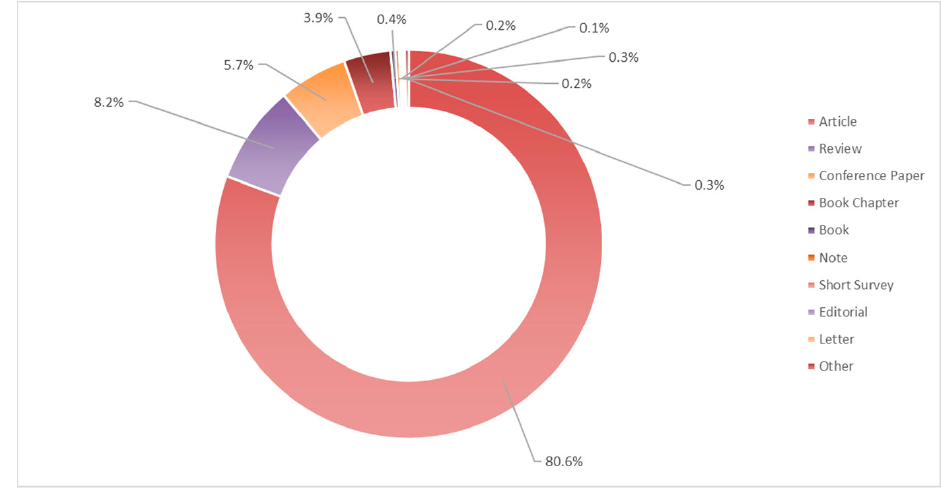
Figure 3. Distribution of documents by type. (Based on data from Scopus).